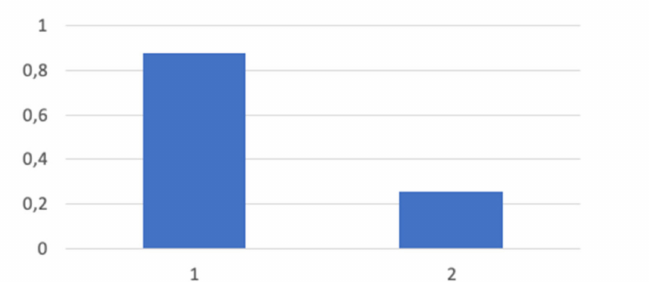
Figure 8. Graph T-Mi, time needed to achieve maximum force measured in seconds.